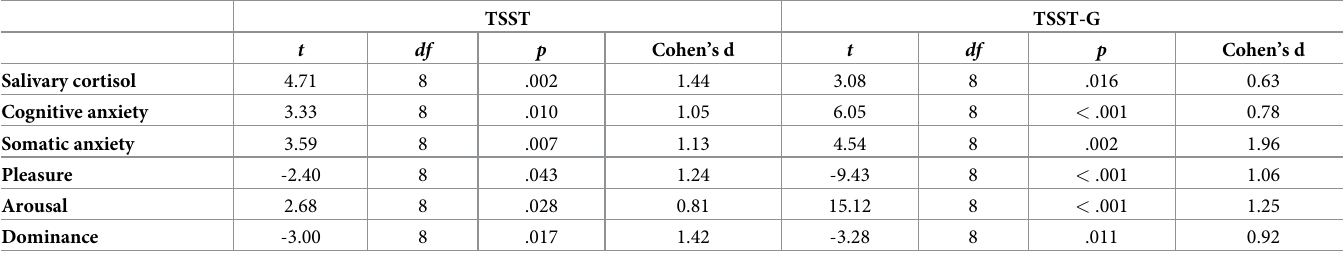
Table 2. Results of the paired-sample t tests.